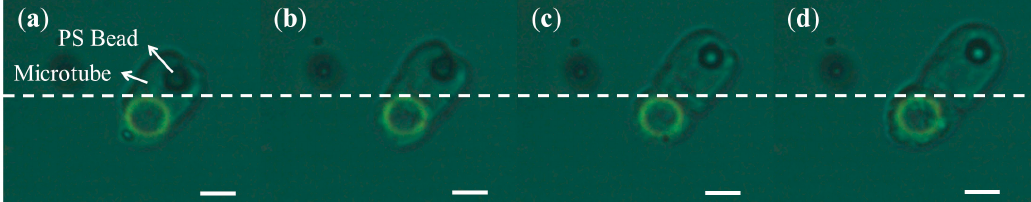
Figure 6. Optical images of a PS ( polystyrene ) bead trapped and manipulated by a hydrogel microtube structure. ( a – d ) Time-lapse images recorded the process of a PS bead been trapped by a hydrogel microtube (scale bar: 5 µm): ( a – c ) 5s interval; ( d ) after 180 s exposure time. Green ring is the projected light pattern. White dash line indicates the initial position of PS bead.